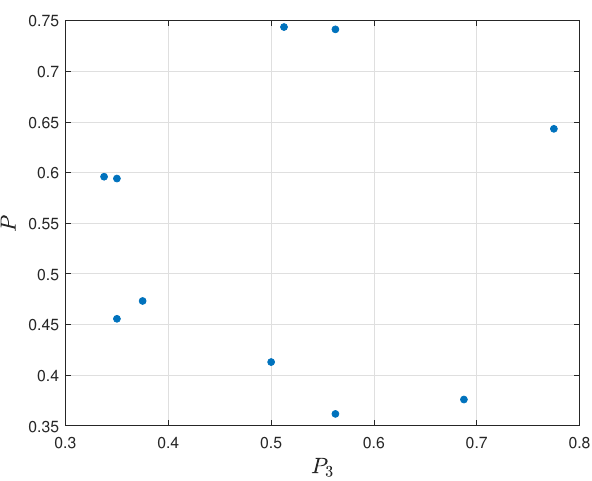
Figure 21. The relation diagram of the Failures per round assessment ( P 3 ) for final assessment P . Table 10. The performance table of the assessment models P 1 – P 3 , final assessment P with their rankings.